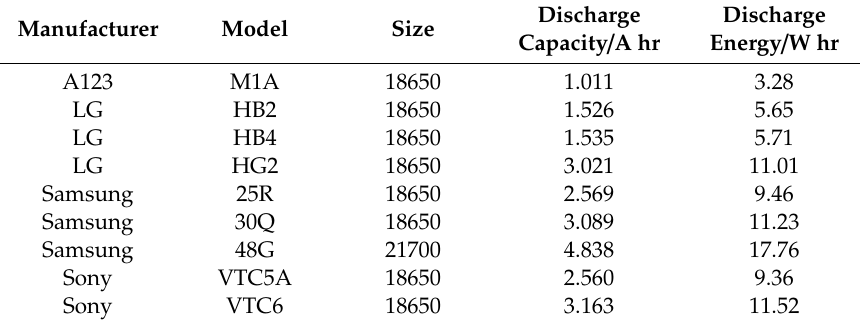
Figure 1. Cell voltages during initial capacity check. Table 3. Properties measured during capacity check.